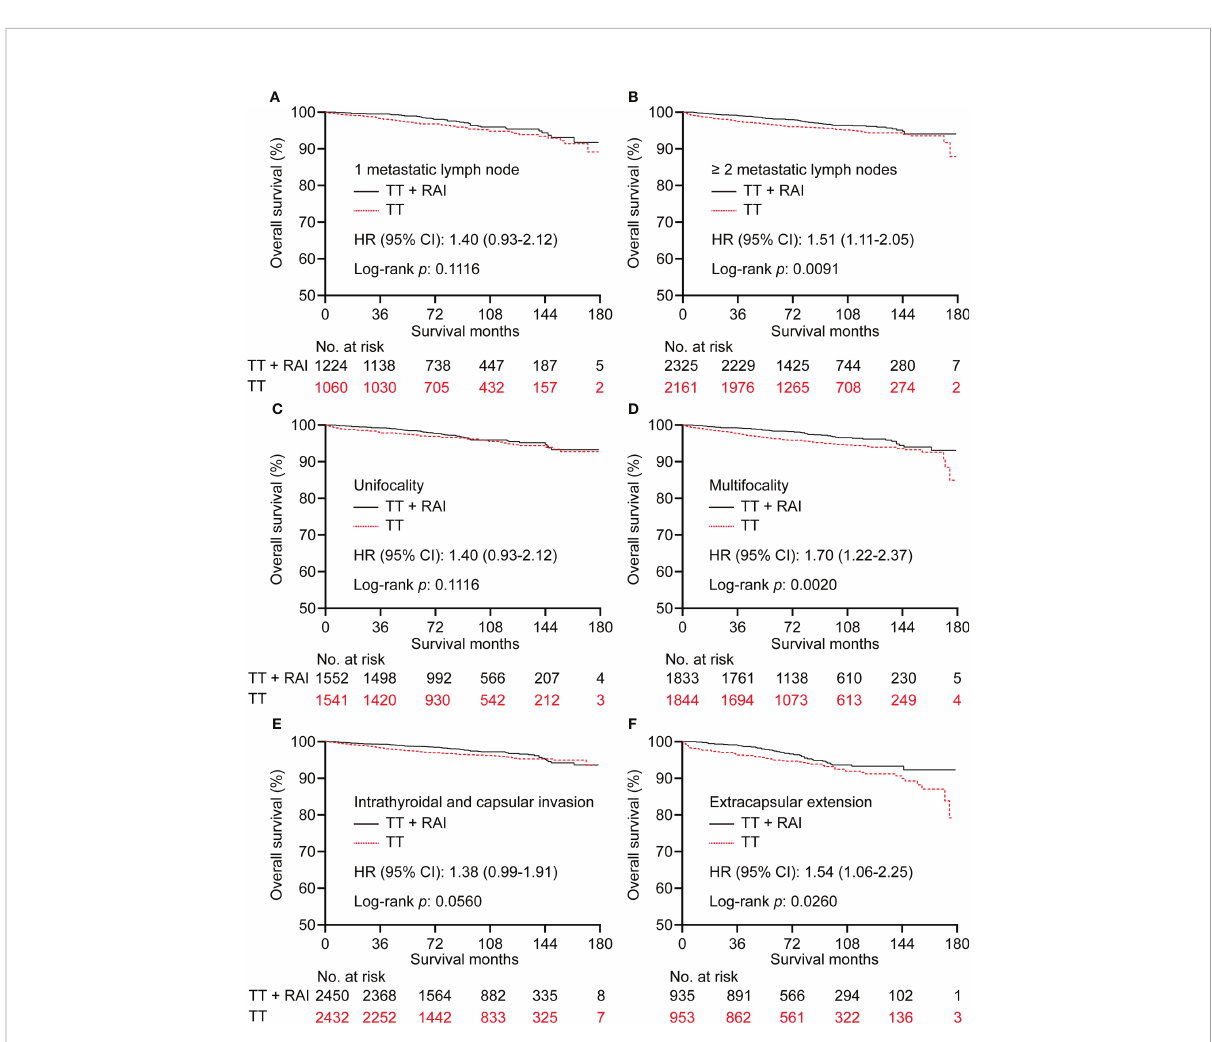
FIGURE 4 Kaplan – Meier curves of OS in PTC patients who underwent TT vs. TT+RAI after PSM strati fi ed by the number of metastatic lymph nodes (A, B) , tumor number (C, D) , and tumor extension (E, F) . OS, overall survival; PTC, papillary thyroid carcinoma; TT, total thyroidectomy; RAI, radioactive iodine; PSM, propensity score